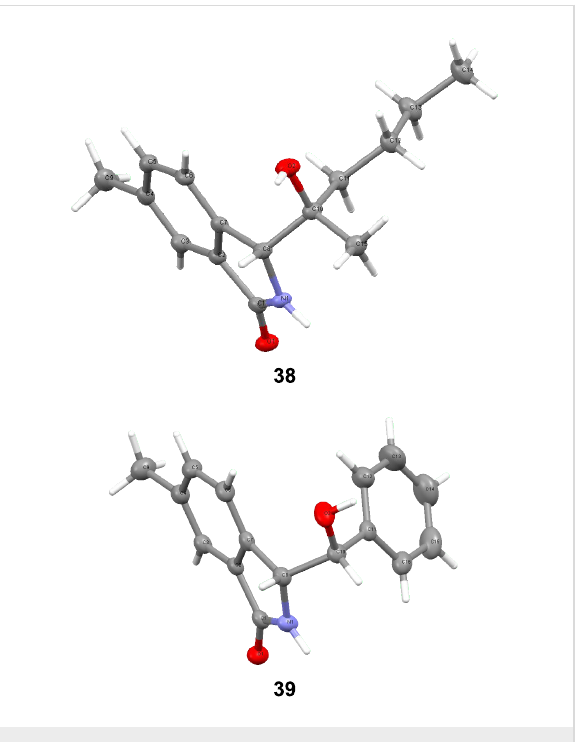
crystalline products 26 , 32 and 40 indicated that the crystals were α -( R* )-3-( S* )-diastereoisomers, while the 1 H NMR